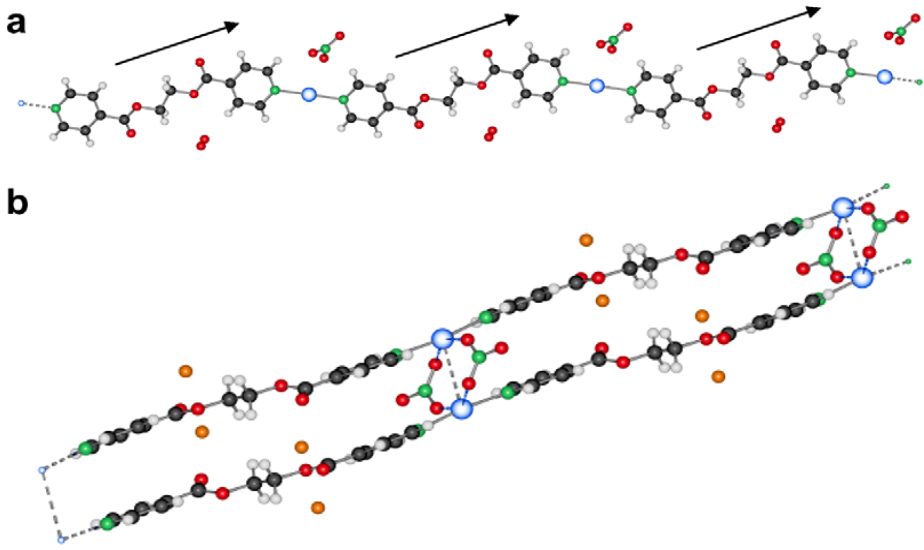
Figure 3. (a) Simple chain motif of compound 3 ; (b) detailed double chain motif of 3 (same color codes as Figure 2, orange in b: water